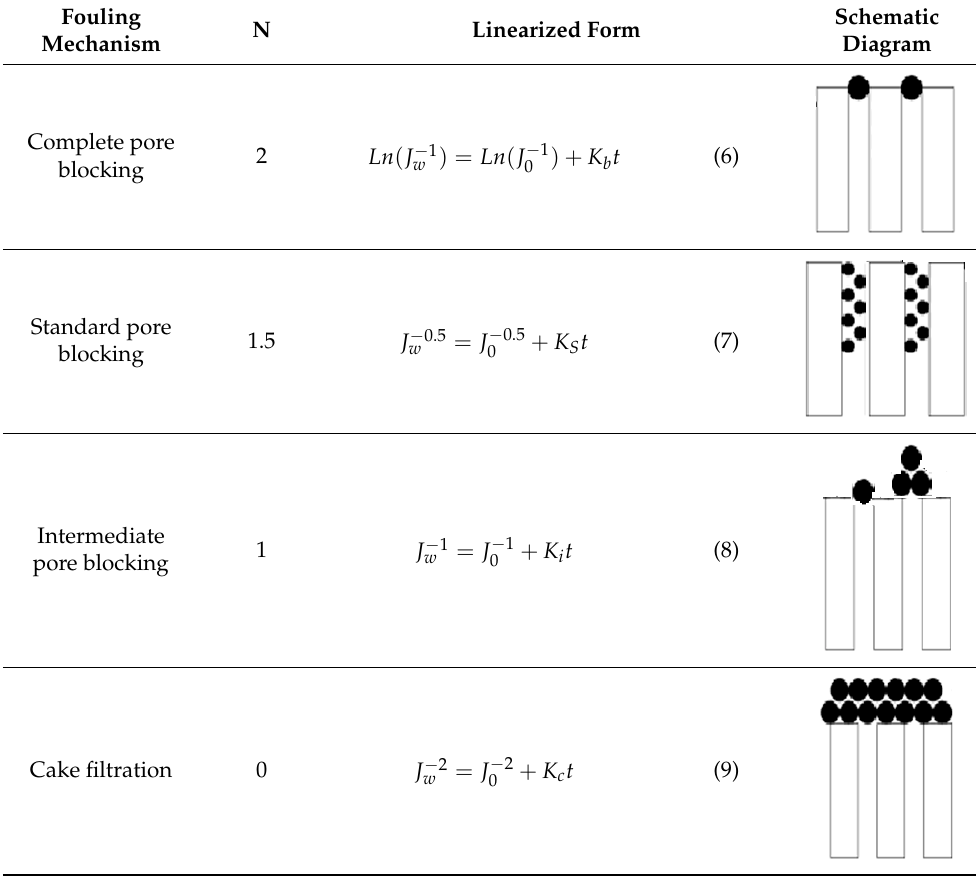
Diagram Diagram Diagram